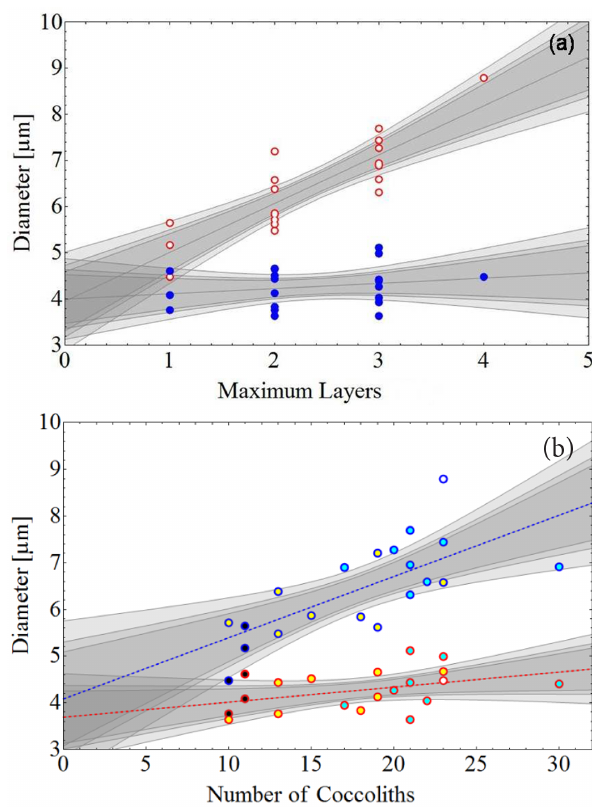
Figure 3. The correlation between inner and outer coccosphere di- ameter is illustrated. The filled blue circles in (a) show the measured values for the inner diameter, while the open red circle display the data for the outer diameter of the coccosphere. In (b) the dots with a blue shell refer to the outer and the ones with a red shell to the in- ner coccosphere diameter. The black filling relates to coccospheres with a maximum thickness of one layer, the yellow to those with a maximum of two layers, the blue to those with a maximum of three layers and the white to those with a maximum of four layers. The fitted slopes as well as the calculated 0.9, 0.95 and 0.99 confidence levels are given by the grey lines.